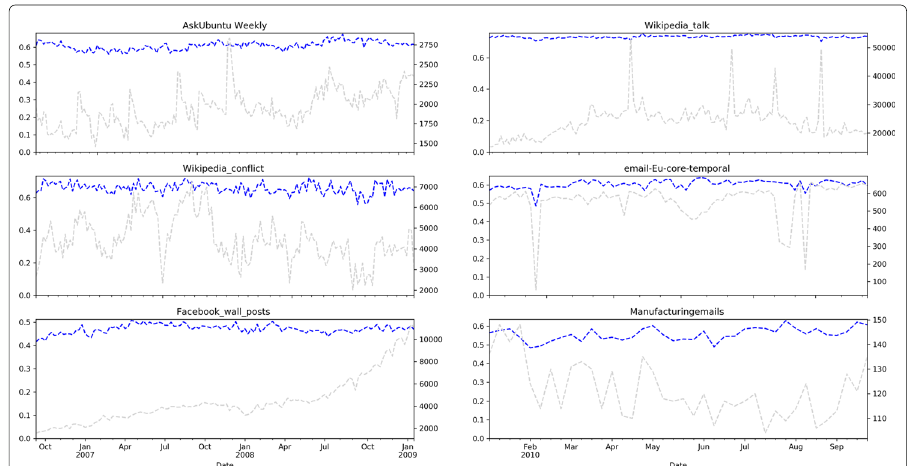
Fig. 4 Temporal Dominance Inequality for the six different datasets, denoted by the strong blue line. The values are denoted by the y-axis to the left. The light grey dashed line denotes the number of participating nodes during each period, i.e., the temporal size of the network. The size scale (i.e., number of nodes) is given by the right y-axis